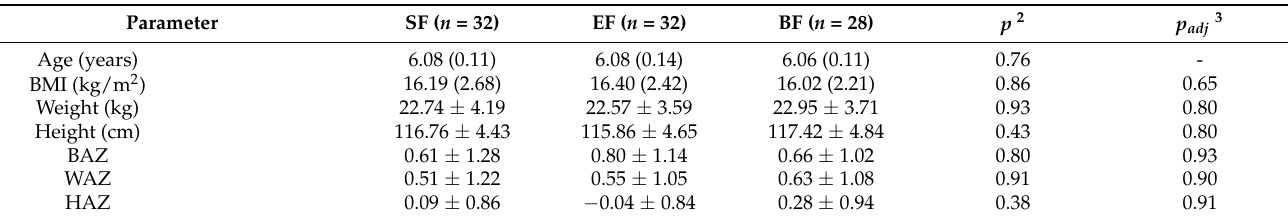
Table 2. Children’s anthropometric characteristics at 6 years old 1